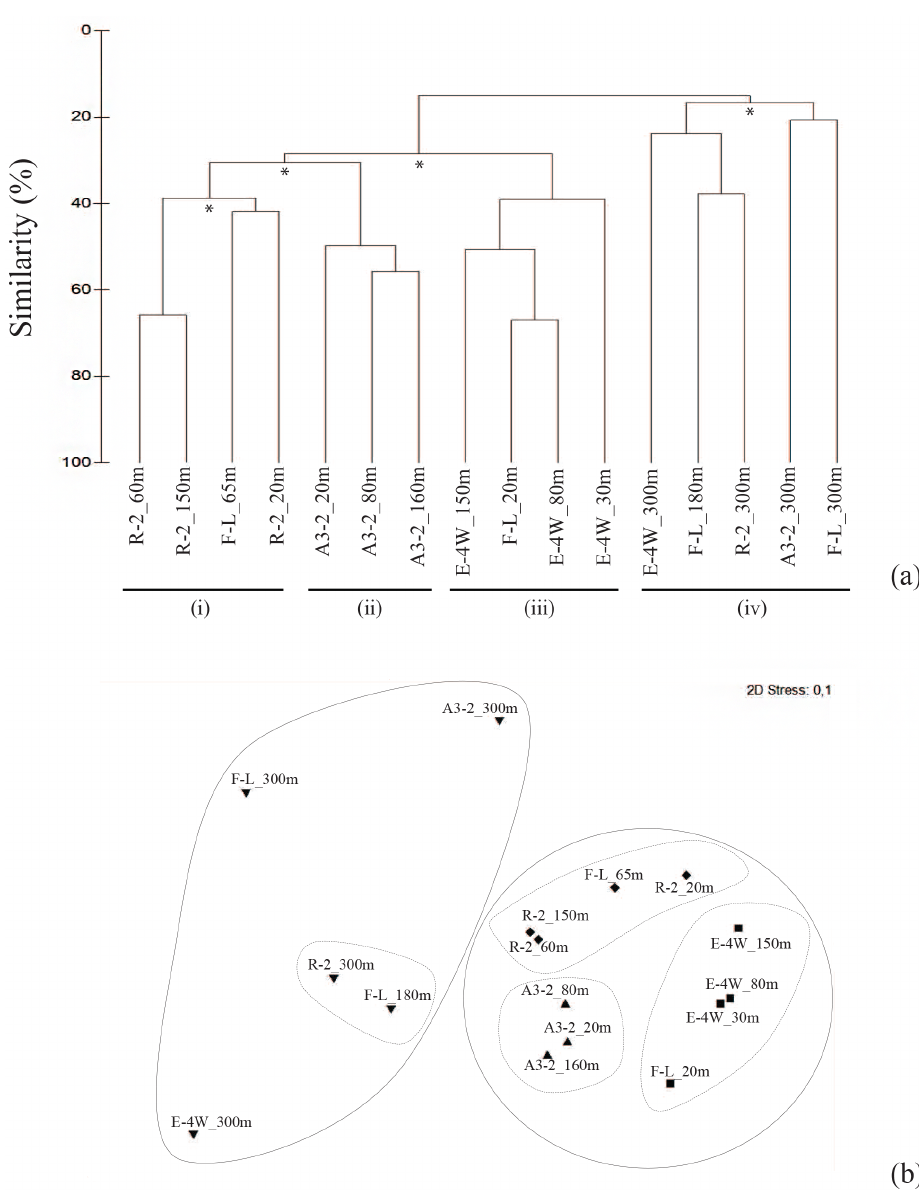
Figure 6. Cluster diagram for the 16 samples constructed from a Bray–Curtis similarity matrix of square-root-transformed OTU abundances. Asterisks at nodes in the dendrogram indicate significant differences between bifurcations ( P < 0 . 05) (a) . Nonmetric multidimensional (nMDS) scaling plots in two dimensions constructed from a Bray–Curtis similarity matrix. Bray–Curtis similarity contours are 15% (solid lines) and 40% (dashed lines) (b)